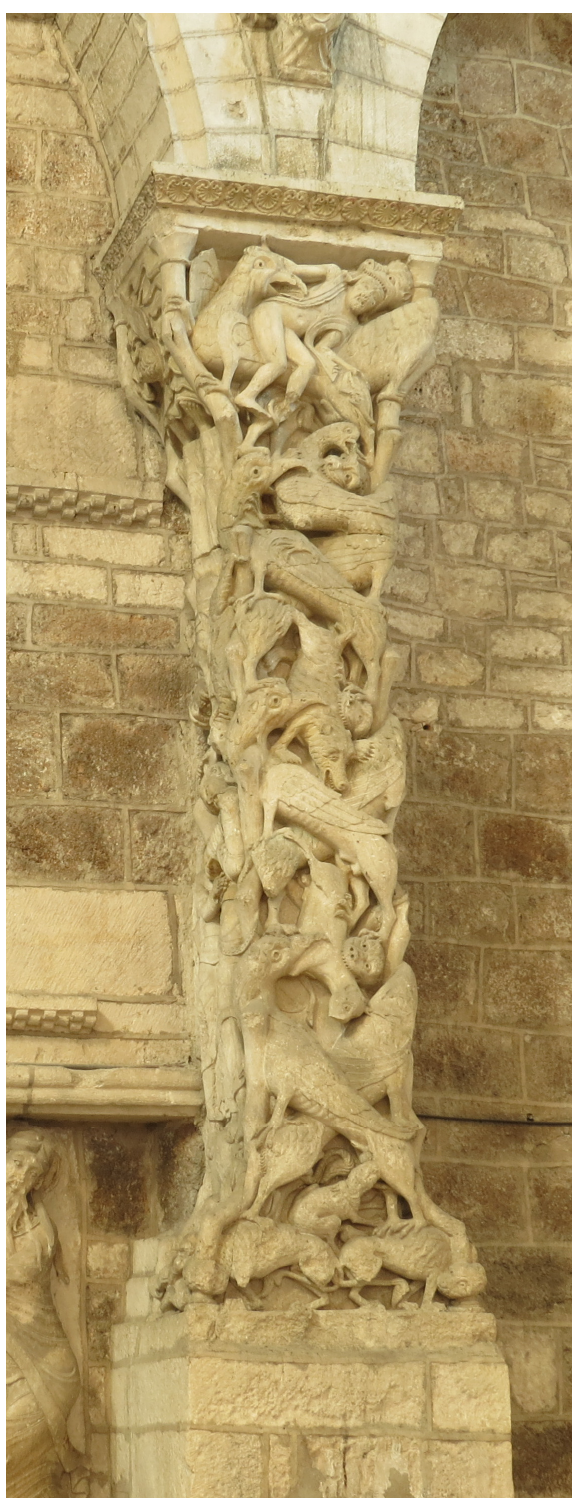
Figure 34. Trumeau, inner west wall, Sainte-Marie-de-Souillac Abbey , ca. 1120–1135, Souillac, Lot, Occitanie, France. ©Author.